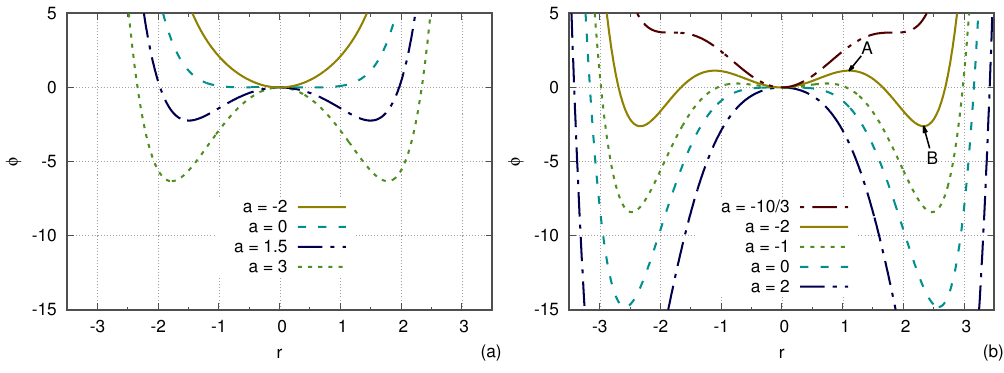
Figure 2. Potential φ ( r ) for various values of a . We recall that a is proportional to the square of the linear growth rate. ( a ) Supercritical case: b = 0. ( b ) Subcritical case: b = 1. Two points are shown by arrows: point A is the potential barrier at r = r min and point B is the saturated value for the subcritical instability, r = r max